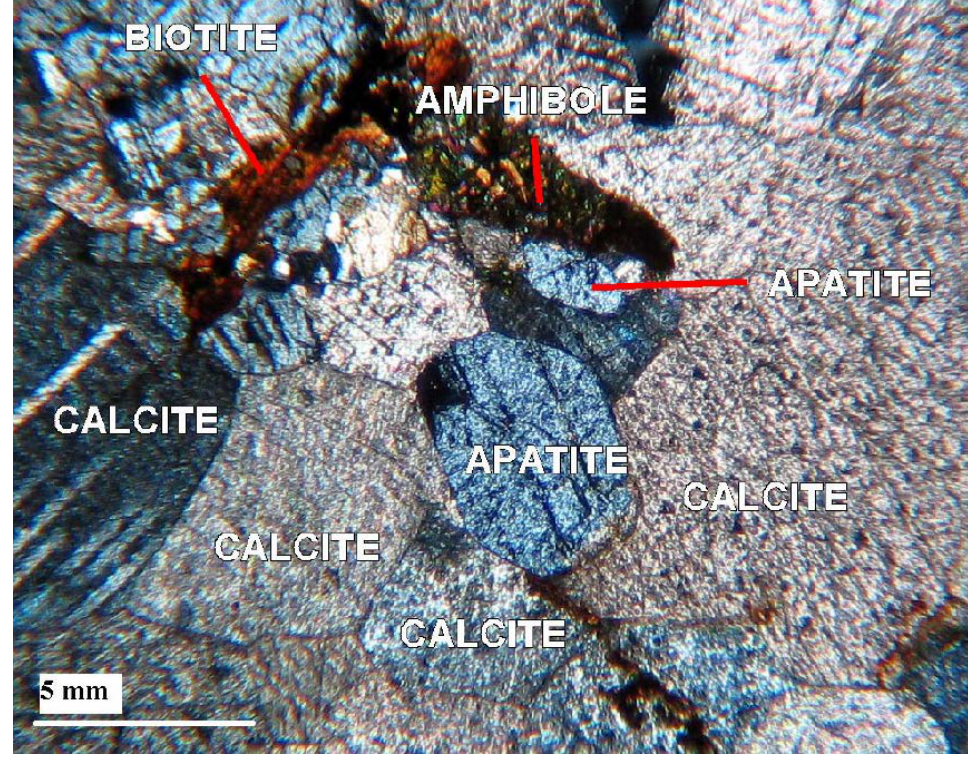
Figure 6. Photomicrograph of Sillai Pattai carbonatite showing the presence of primary apatite. The reflectance spectrum of the carbonatite samples obtained through the ASD spectroradiometer effectively captured the absorption features of Nd at 745 and 810 nm (Figure 7). The strength of these features is strongest in the sample SP9 followed by the samples SP1, SP7, and SP8, which corresponds either to the higher concentration of Nd in these samples or to the coarse-grained size of the REE minerals present in the samples. In the remaining samples, these features are either very weak, e.g., in SP2a, SP3d, SP4, SP5b, and SP6, which corresponds to the lower concentration of Nd in the samples, or absent, e.g., in SP2b, SP2c, SP3a, SP3b, SP3c, and SP5a. The features may also be masked either by the featureless spectra of other minerals, e.g., magnetite, in this electromagnetic spectrum range or because of the lower albedo of a sample, e.g., in the spectrum of the SP2a collected at the darker part of the sample (Figures 4 and 7). Samarium (S)-related absorption features, usually present at wavelengths 1093, 1251, and 1408 nm in the spectral profile along with Nd were not noticed in the spectrum of any of the samples.